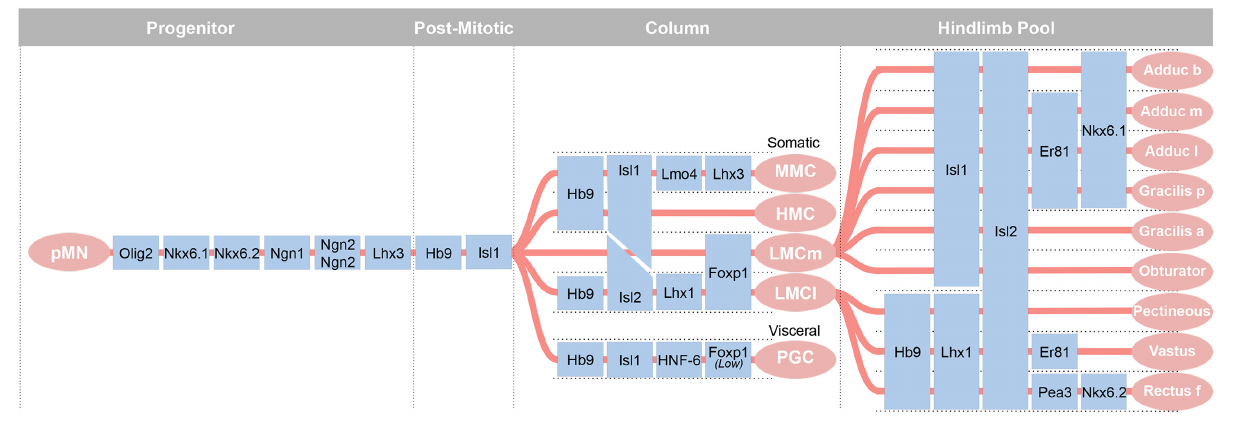
pools. Motor pools are clusters of motor neurons that innervate a single muscle. A transcription factor code is emerging to define each of the over 200 motor pools that innervate distinct muscles. Adapted from Alaynick et al.